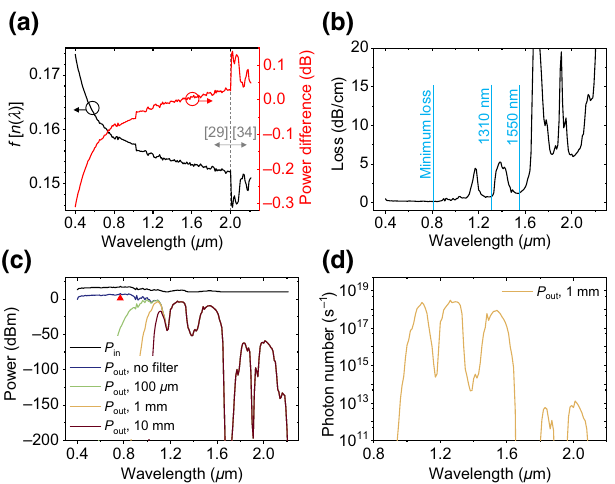
FIG. 4. (a) Calculated f [ n (λ) ] from Eq. (3) and the output power threshold difference caused by the corresponding TOC change, as referenced to the value at 1550 nm. (b) Absorption loss spectrum of acrylic, taken from Refs. [29,34]. The losses at the 1310 and 1550 nm communication bands are marked. The minimum loss is about 0.15 dB/cm at visible